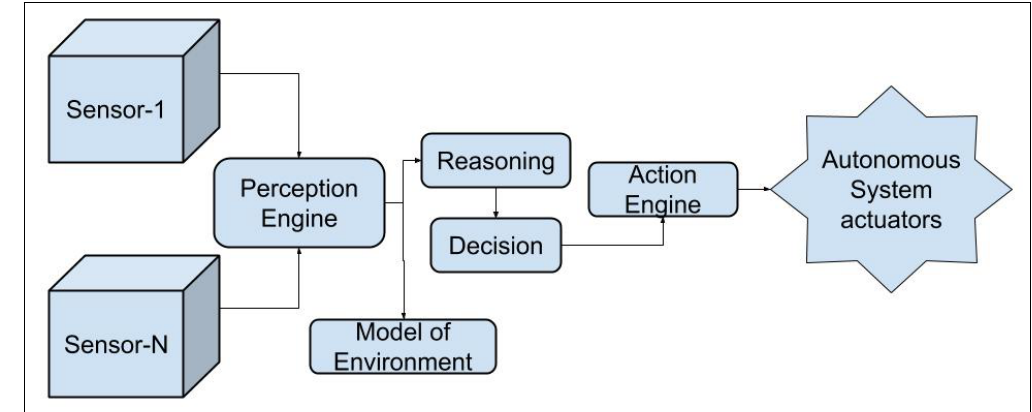
Figure 1. High level Perception